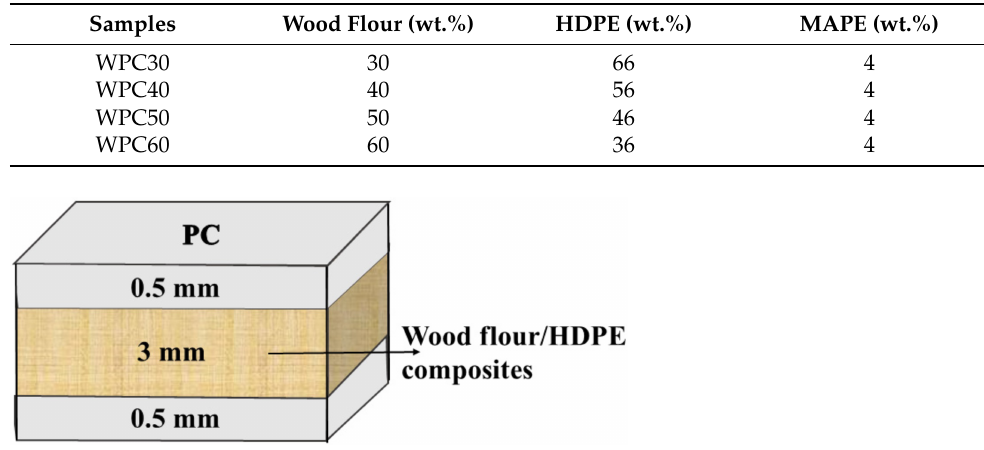
Figure 1. Schematic diagram of the multilayered WPCs with sandwich